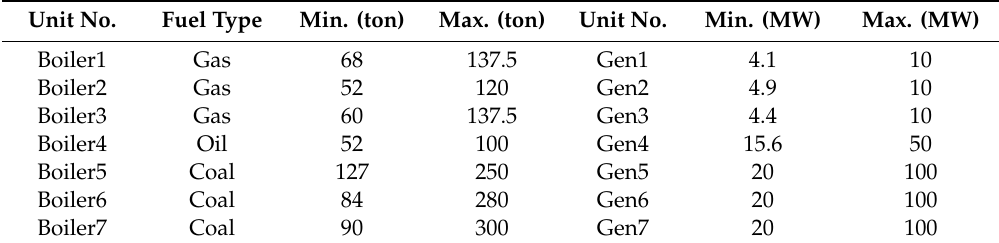
Table 2. Maximal and minimal limits of boiler flows and generators.